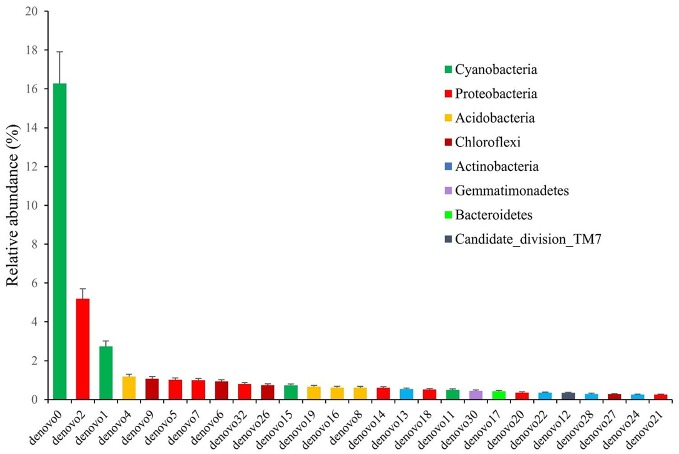
The relative abundance of OTUs with average proportions of more than 0.5%. The Standard Deviations (SD) were shown with error bars.